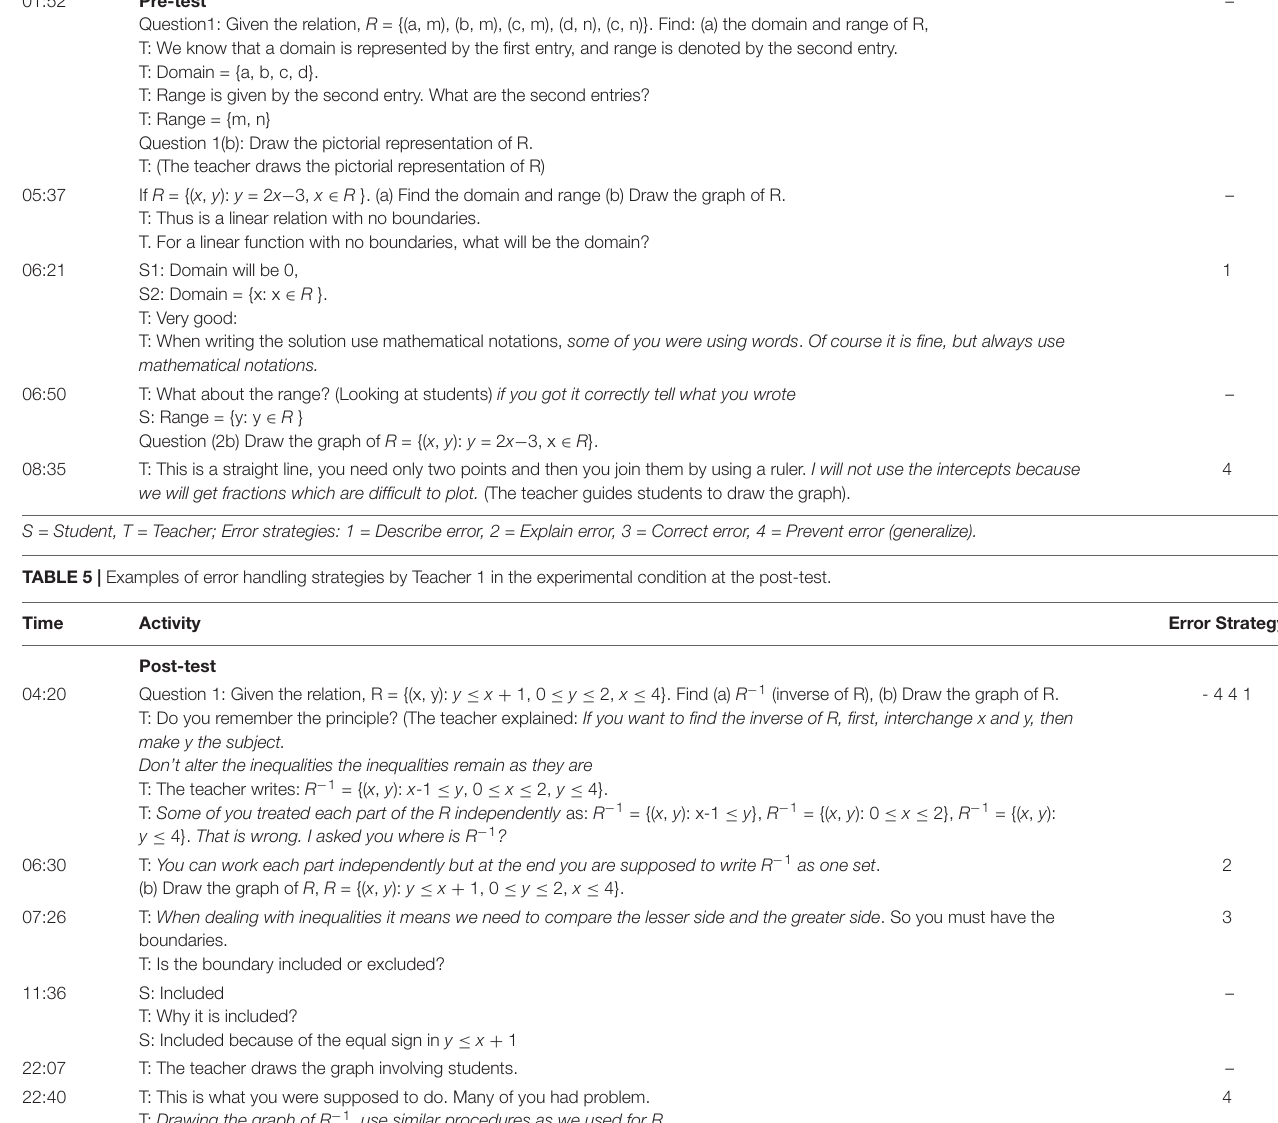
TABLE 4 | Examples of error handling strategies by Teacher 1 in the experimental conditionat the pre-test. Time Activity Error Strategy